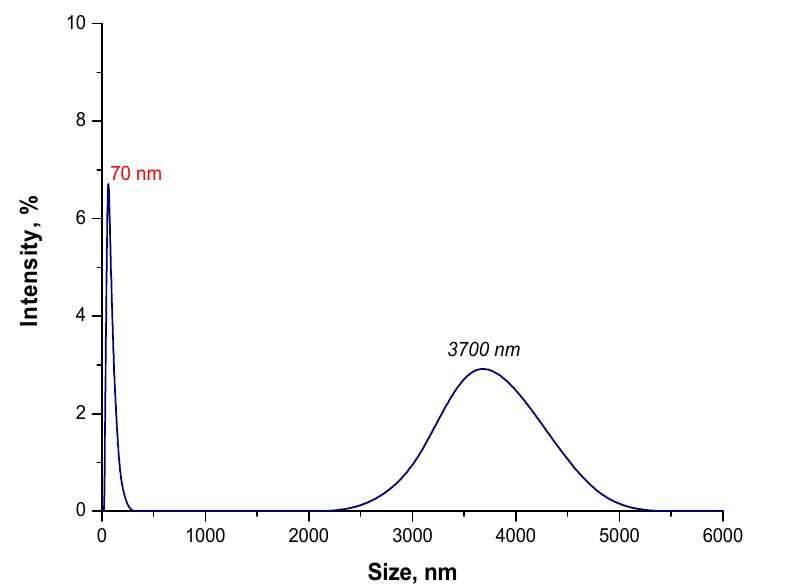
Figure 7. The size analysis of Fe 3 O 4 @Au particles obtained in the oil and water environment. In the suspension, as a result of the synthesis of Fe 3 O 4 @Au particles in the oil and water environment, the particles with a size of 70 nm were obtained. However, agglomerates of particles with a size of approximately 3700 nm were also noticed. Thus, it may be concluded that the reaction environment affected the size of the obtained particles. In the oil and water environment, the oil droplets dispersed in the resulting O/W emulsion create a physical barrier between nanoparticles in the suspension; thus, limiting interactions between nanoparticles, which might lead to the formation of agglomerates. Additionally, Arabic gum present in the suspension causes the occurrence of steric stabilization. This biopolymer adsorbs on the surface of magnetic nanoparticles, increasing the distance between them. Due to the presence of agglomerates with a size of 3700 nm in the tested suspension, the sonication process was used at a later stage in order to disintegrate them. After ultrasound treatment, the suspension was re-analyzed using the DLS method and the obtained results are presented below in Figure 8.